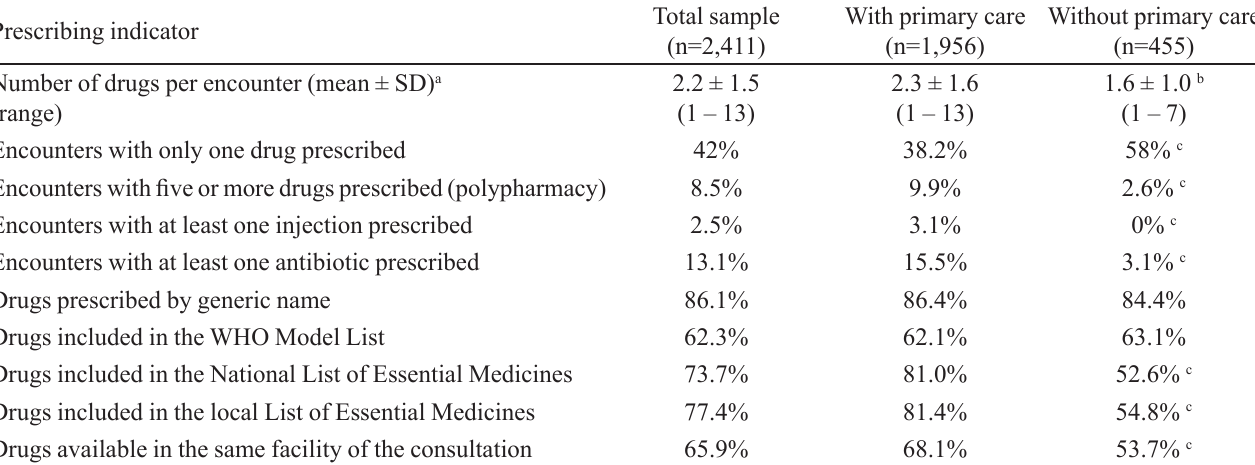
TABLE I - Indicators of rational use of medicines proposed by the World Health Organization (WHO), as assessed in outpatient clinics in eight Brazilian cities* (2006-2008), considering the different levels of health care delivery – centers with or